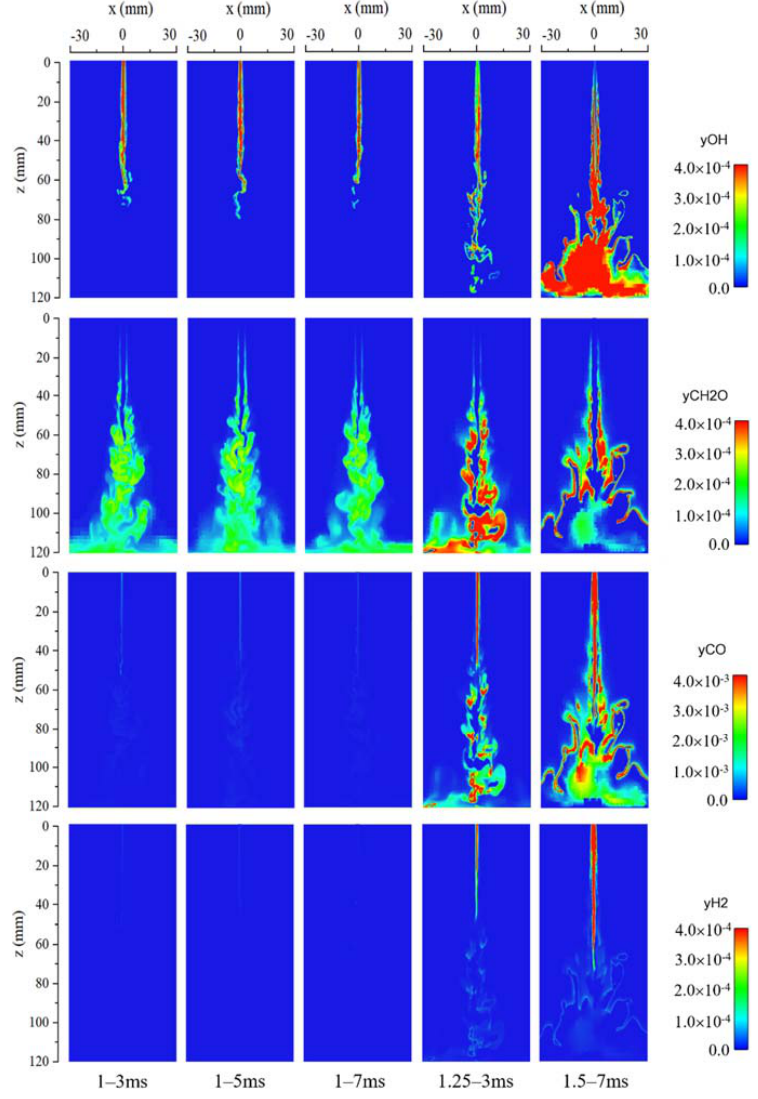
Figure 14. Distribution of major species in the main chamber at 3 ms after the hot jet appeared.